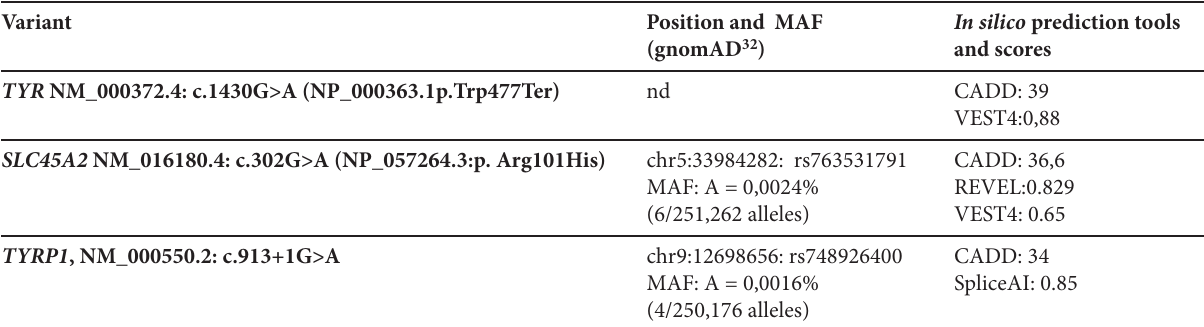
Variant Position and